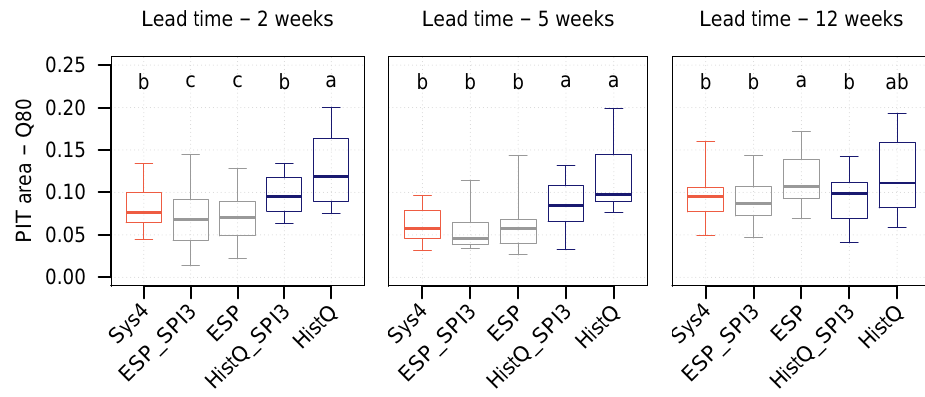
Figure 10. Same as Fig. 8 for deficit